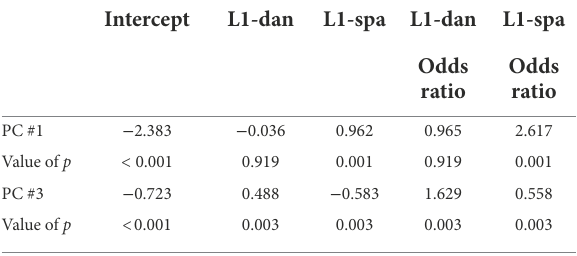
TABLE 5b Multinomial logistic regressions with PC #2 as baseline (L2-Danish baseline).